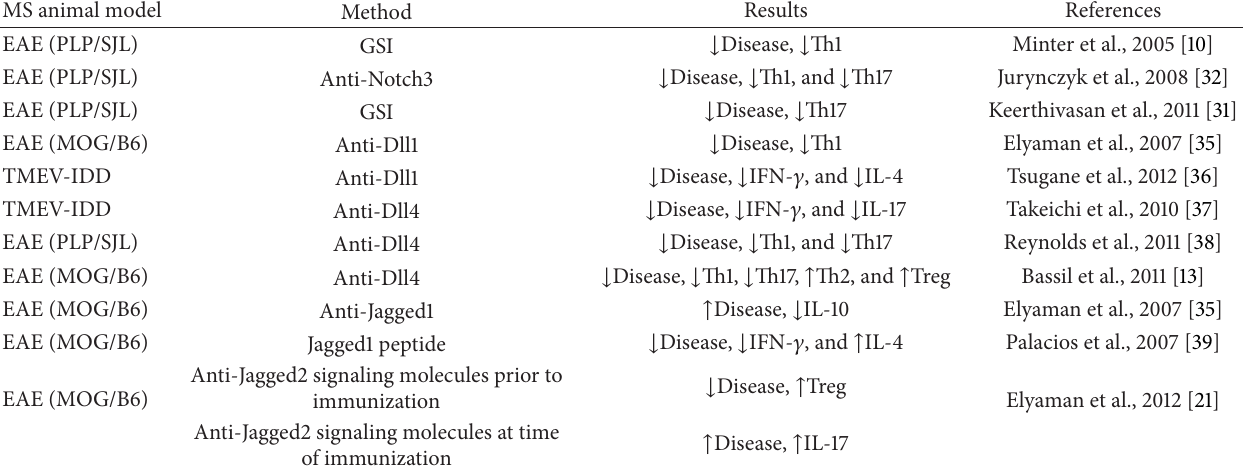
Table 2: Notch and animal models of